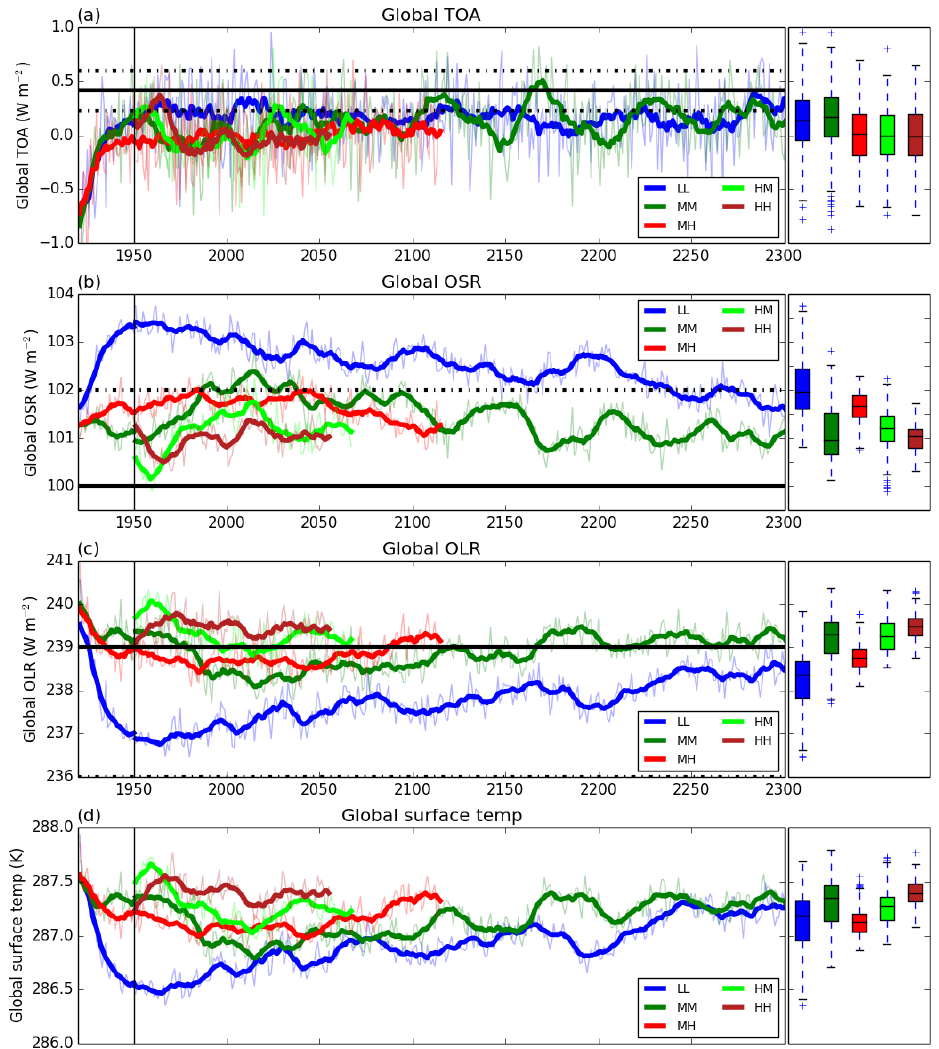
Figure 2. Time series of globally averaged quantities for three ocean resolution spinup-1950 simulations ( x -axis nominal years: 1920– 1950 here) and five control-1950 simulations initialised from these conditions ( x -axis nominal years: 1950–2300). (a) Top-of-atmosphere (TOA) radiation, Wm − 2 ; (b) outgoing shortwave radiation (OSR), Wm − 2 ; (c) outgoing longwave radiation (OLR), Wm − 2 ; (d) surface temperature, K. The horizontal black lines are estimates (solid) and uncertainty (dashed) of fluxes from Wild et al.